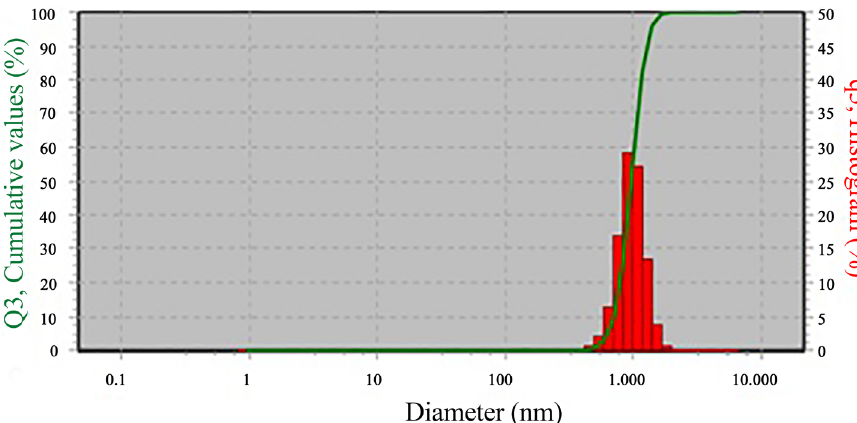
Figure 5. Particle size distribution of μTiO